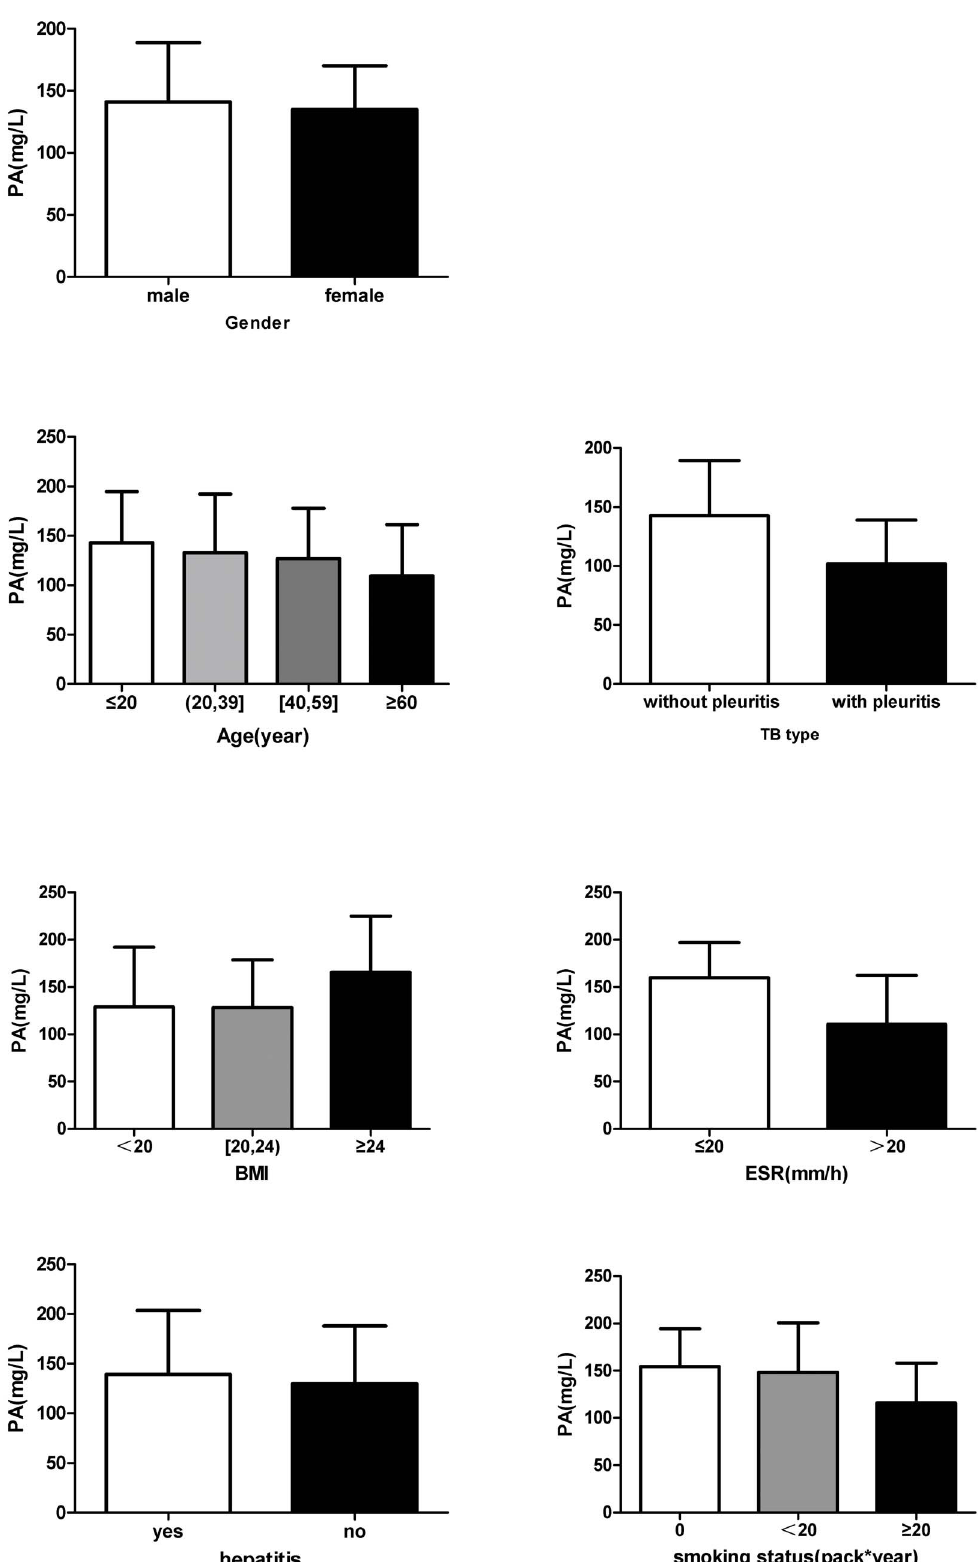
Figure 1. The serum PA levels in different subgroups of TB patients. There were significant differences in the serum PA levels between following subgroups: pleuritis and lung tuberculosis, TB patients with higher ESR ( $ 20 mm/h) and normal ESR ( , 20 mm/h), TB patients with higher smoking status ( $ 20 year 6 pack) ( P , 0.01).